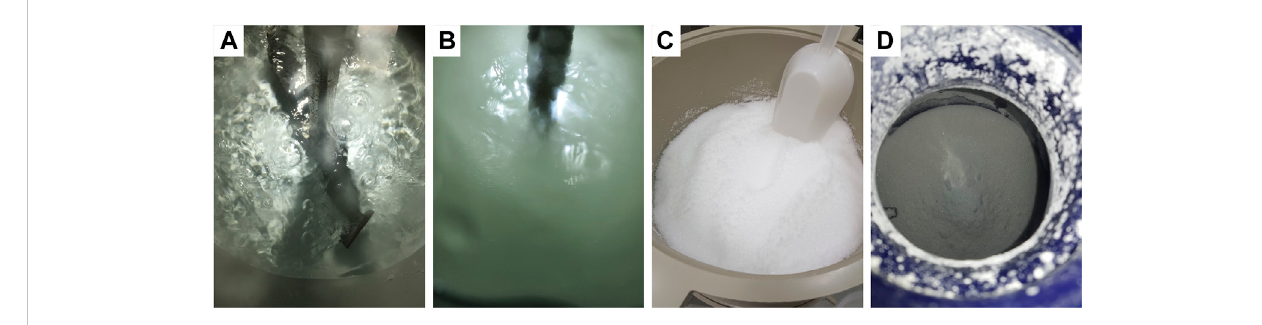
FIGURE 2 (A) Boilingofsolutionwithstirring, (B) RecrystallizedNaIcrystalwithmotherliquor, (C) FiltratedandwashedNaIcrystalonthe fi lterunit, (D) DriedNaI powder in the conical dryer.